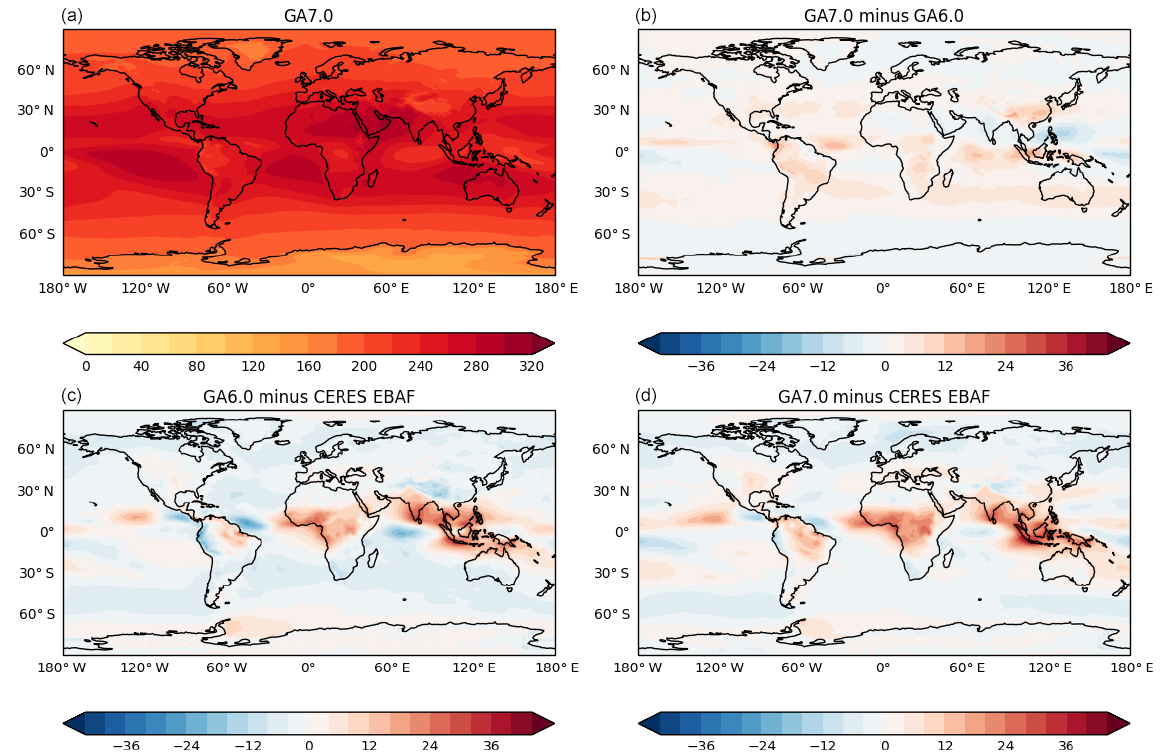
Figure 16. Annual mean top-of-atmosphere outgoing LW radiation (Wm − 2 ) using the same simulations, observational dataset and layout as Fig.